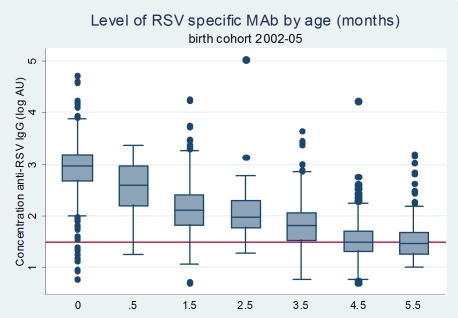
The level of RSV-specific matAb by age (months) in a birth cohort, Kilifi Kenya.Box plot of log10AU Ab levels for age categories defined as 0 months (cord), 0.5 (>0-<1), 1.5 (1-<2), 2.5 (2-<3), 3.5 (3-<4), 4.5 (4-<5) and 5.5 (5-<6) months. The red horizontal line defines the cut-off for seropositivity of 1.5 log10AU.